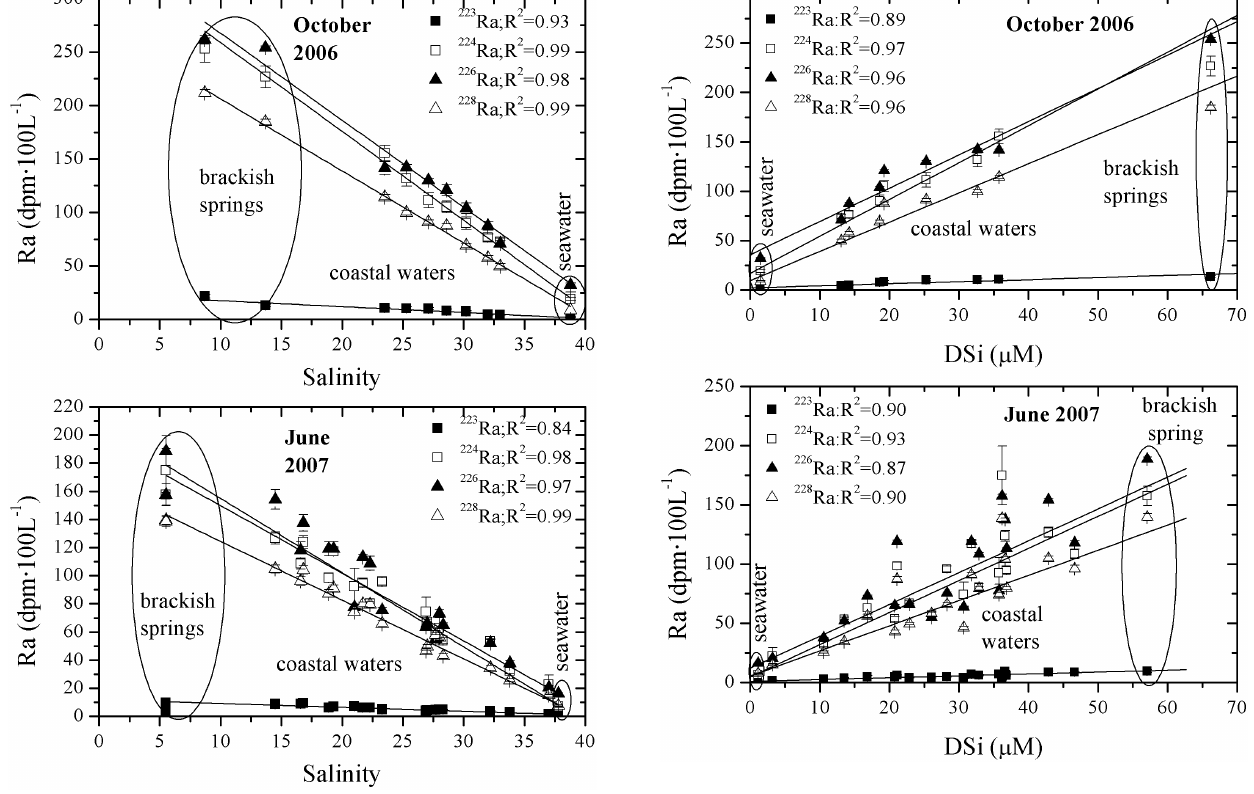
Fig. 5. Ra versus salinity plots for surface coastal waters, seawa- ter and brackish spring groundwater samples indicating a mixing pattern of two end-members: seawater and groundwater.